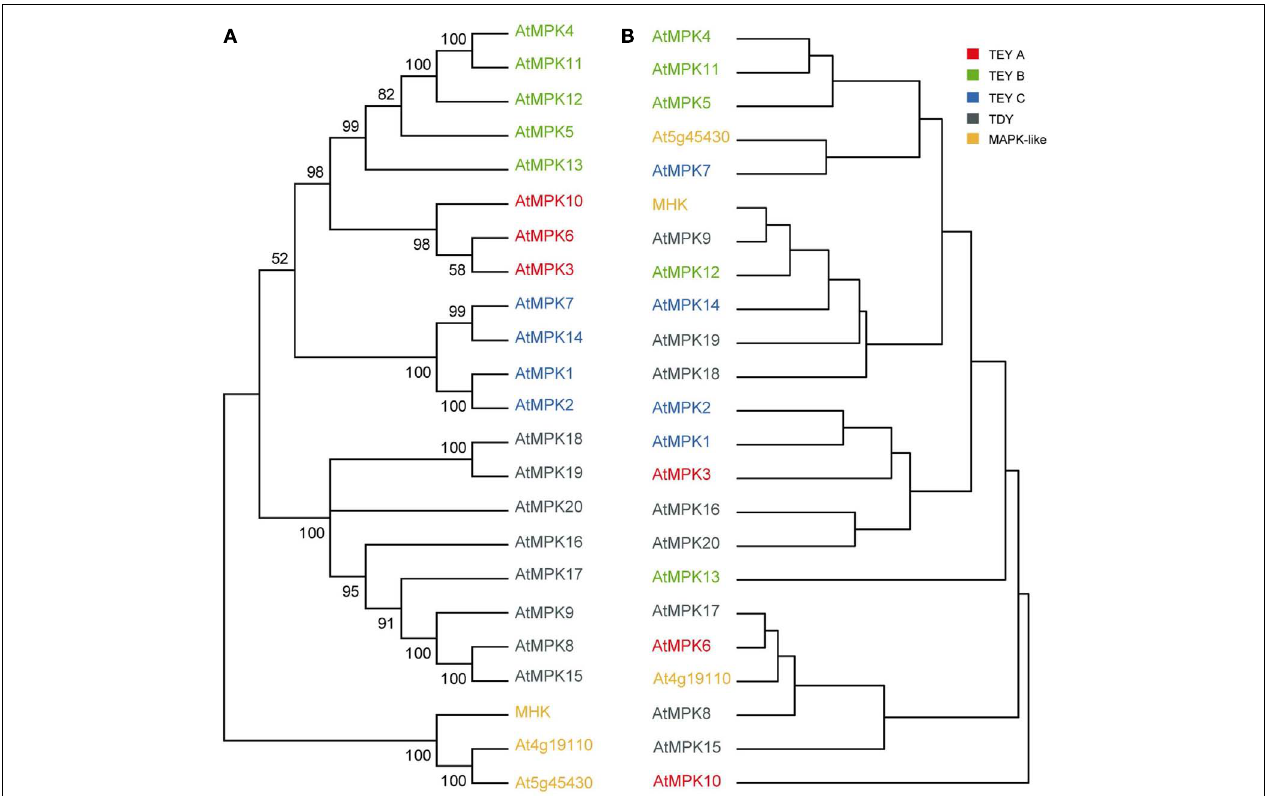
co-expression data from the AtGenExpress tissue series including all 20 canonical MAPK s and all three MAPK-likes of AT. (A,B) The four major clades of canonical MAPKs (TDY,TEY-A,TEY-B,TEY-C) and the MAPK-likes are indicated by different